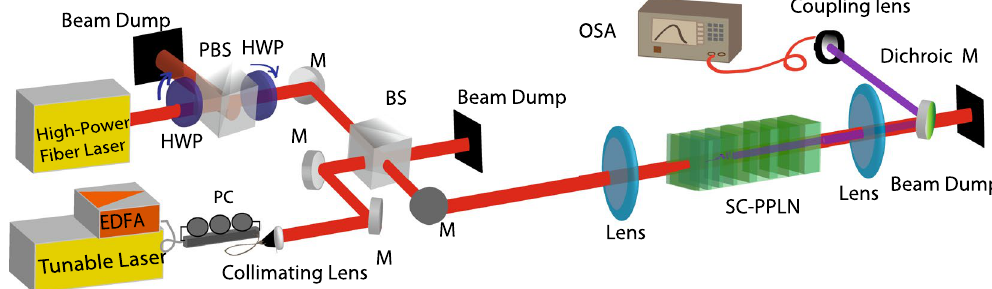
Figure 6. Experimental setup to evaluate SFG in an SC-PPLN with a high-power fiber laser as a pump and a tunable CW laser as a control signal, EDFA: erbium doped fiber amplifier, PC: polarization controller, M: mirror, BS: beam splitter, PBS: polarization beam splitter, HWP: half-wave plate and OSA: optical spectrum analyzer. The light from the high-power laser is combined with the light from the tunable laser after polarization controlling, in a 50:50 beam splitter and loosely focused in the SC-PPLN. The higher harmonics are separated by a dichroic mirror and coupled to an optical spectrum analyzer. SHG in the SC-PPLN is evaluated using the high-power laser by turning the tunable laser